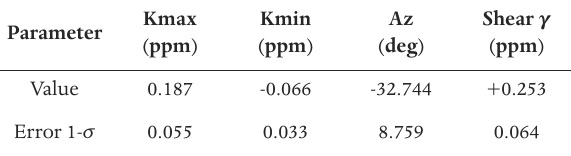
Table 2. Deformation Parameters of the whole region (11 sta- tions). The principal axes of the tensor are shown in Figure 8. The strain in this region consists of a small amount of compression in the direction approximately N 58°E, and about three times more extension at N 32°W (±8 degrees).